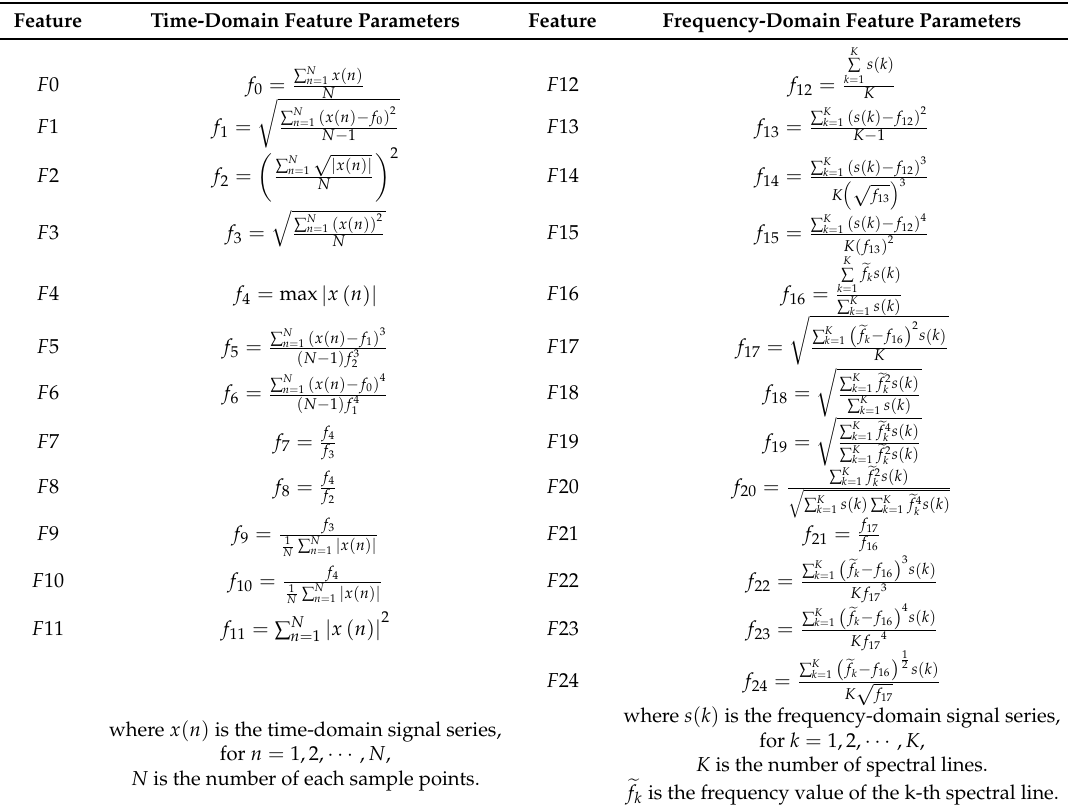
Table 2. The feature